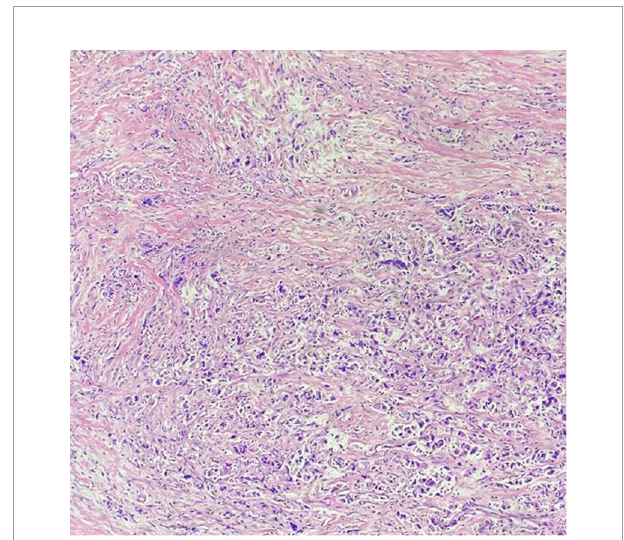
FIGURE 2 | Tumor parameters. CA-199 concent (A) . CEA consent (B) . Red line, upper limits of normal; yellow line, lower limits of normal; blue line, actual